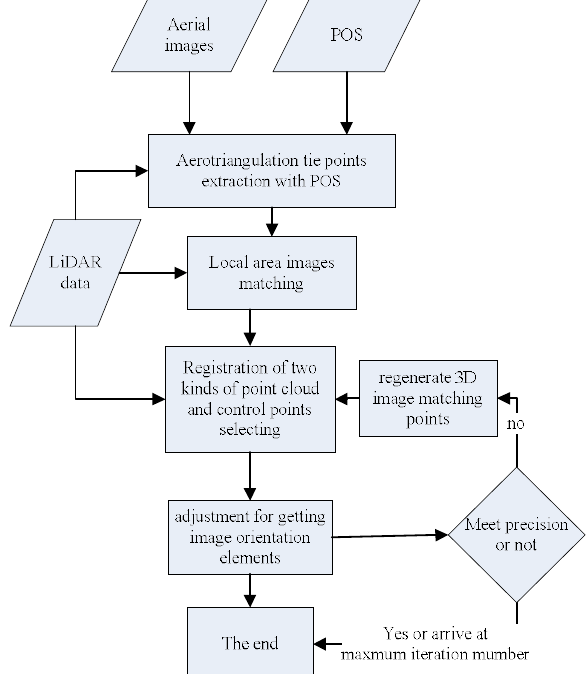
Figure 2. Data processing flow of aerotriangulation